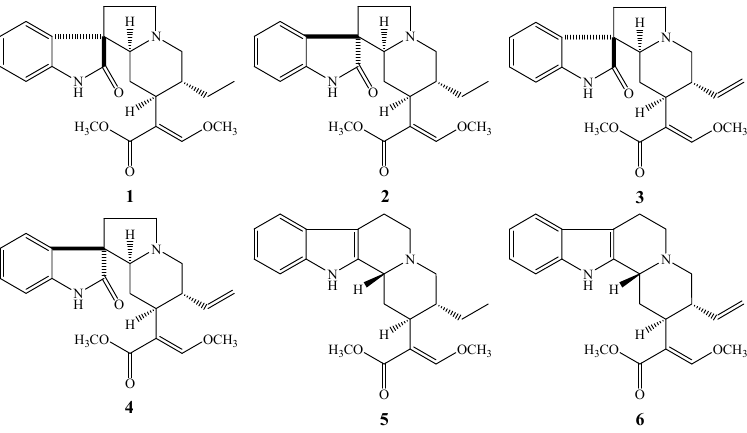
Figure 1. Chemical structures of rhynchophylline ( 1 ), isorhynchophylline ( 2 ), corynoxeine ( 3 ), isocorynoxeine ( 4 ), hirsutine ( 5 ) and hirsuteine ( 6 ).